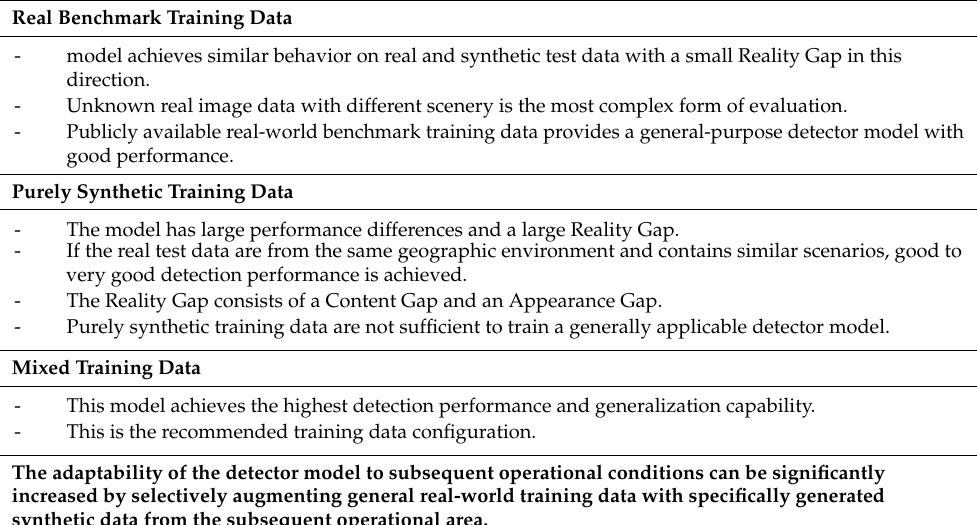
Table 3. Evaluation results of different training data